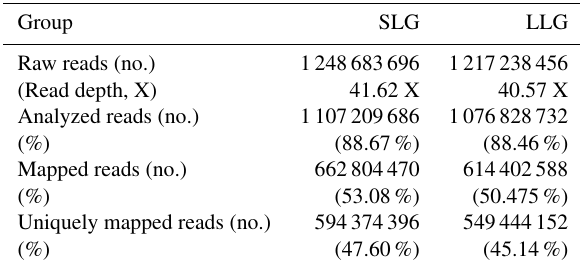
Table 2. Summary of sequencing results and reads alignment. Group